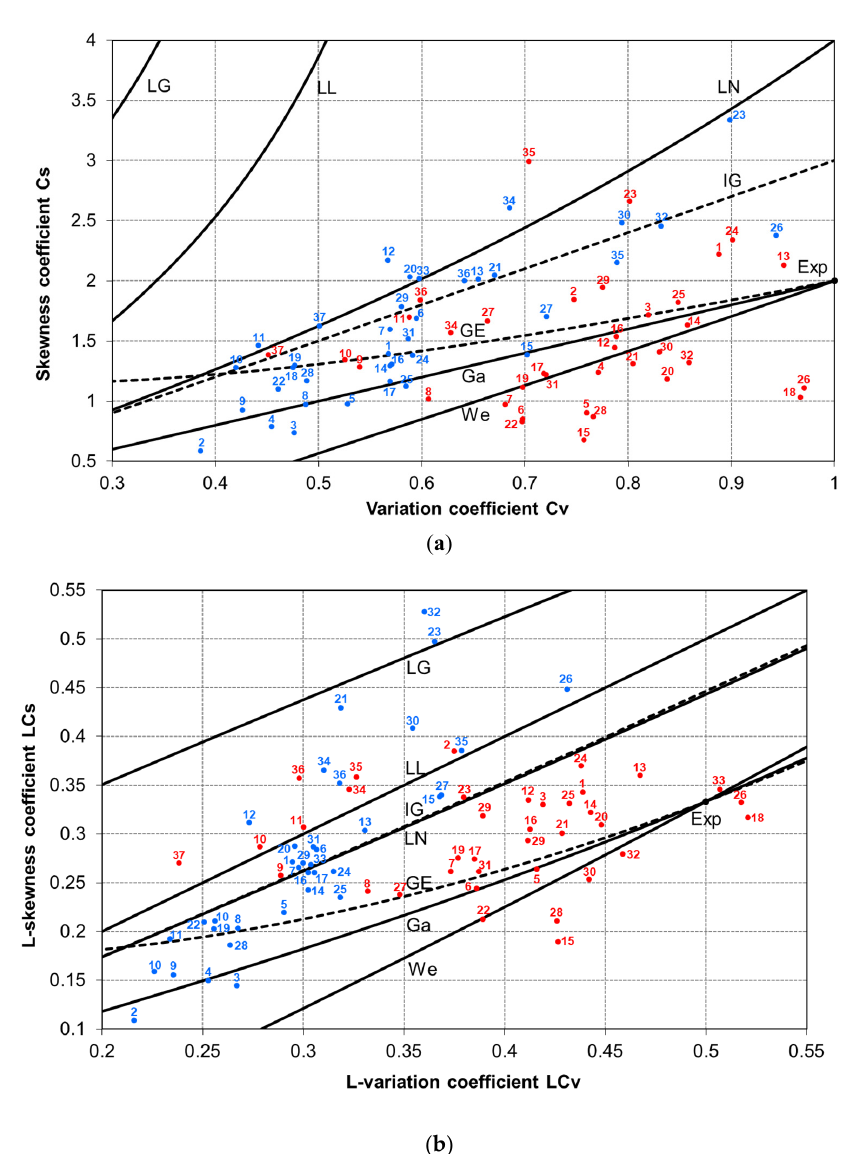
Figure 3. Skewness coefficient versus variation coefficient for two-parameter distributions and Polish data of summer (red color) and winter (blue color) peak flows for 37 gauging stations: ( a ) conventional moment ratio diagrams of Cs vs. Cv; ( b ) linear moment ratio diagrams of LCs vs. LCv. Key to the